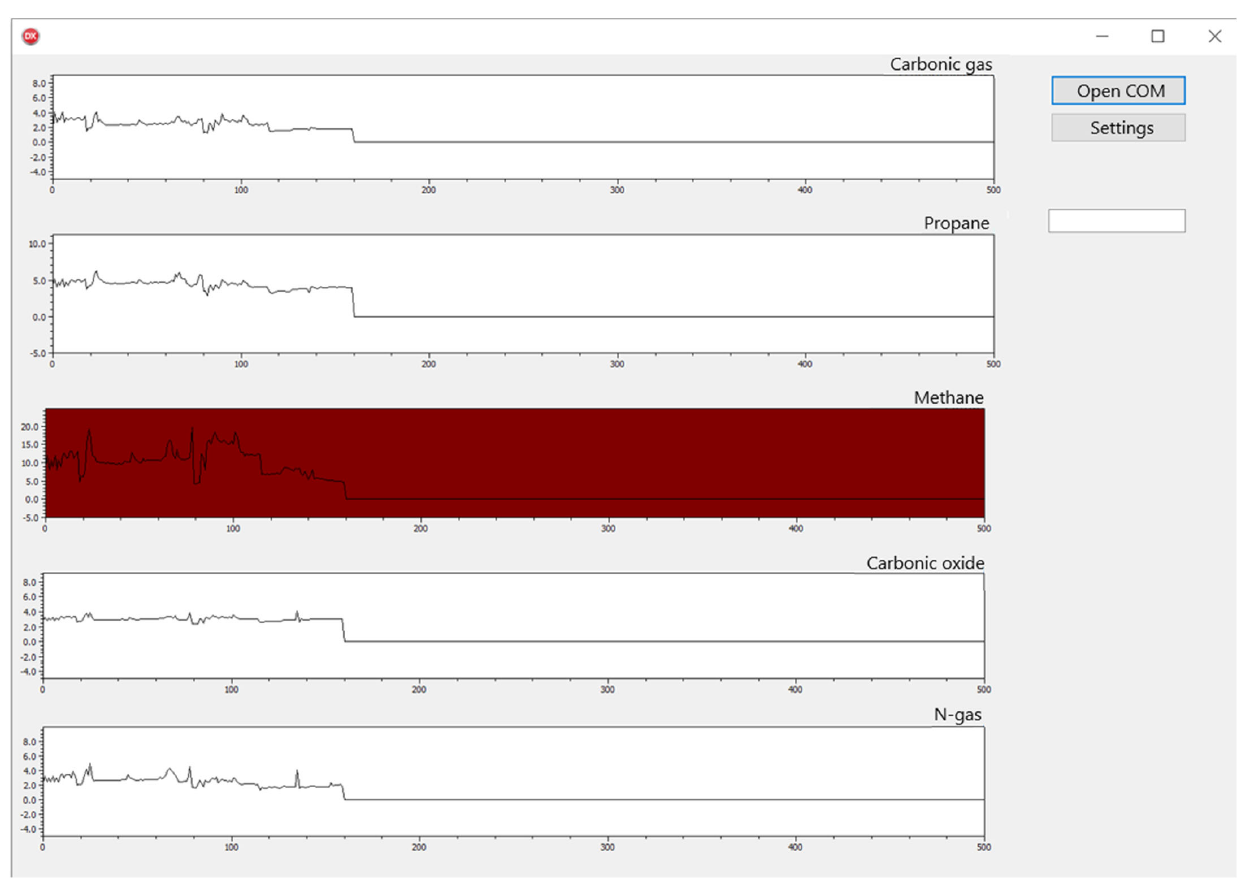
Figure 6. Display of the system’s response to exceeding the permissible parameters of the gas content.